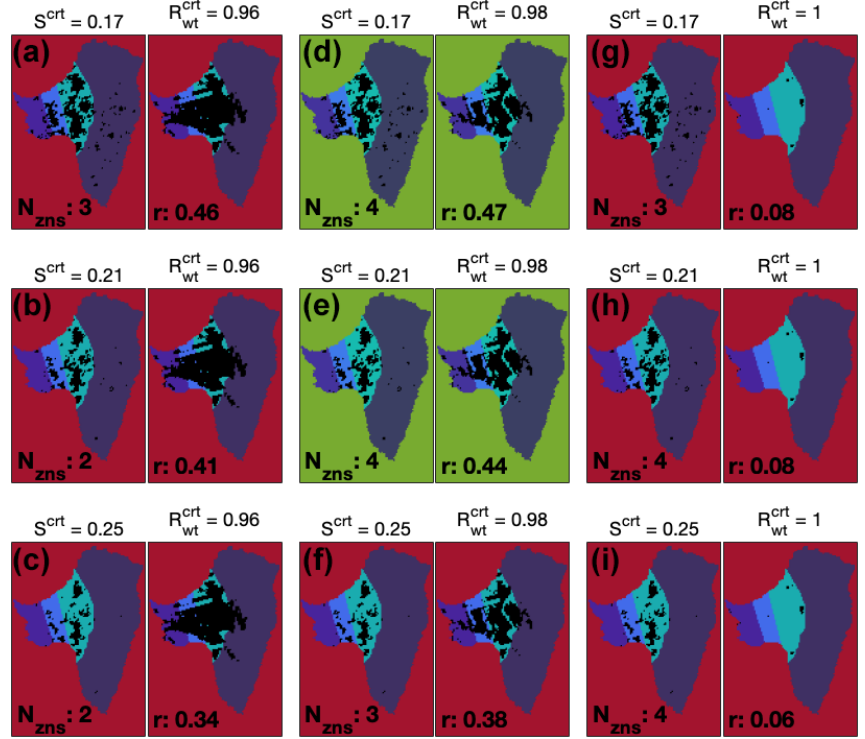
Figure B3. Select S crt (observed) and R crt wt (modeled) mask combinations from the W r = 0 . 1m, c s = 0 . 5m − 1 , k q = 5 × 10 − 2 m 7 / 4 kg − 1 / 2 , and k Q = 5 × 10 − 4 m 7 / 4 kg − 1 / 2 model run, plotted over the four zones used for the first comparison criterion (also shown in Figs. 3, 7). N zns indicates the number of zones that meet criterion 1, and r is the overall correlation between mask pairs. Background color indicates successful (green) and unsuccessful (red) matches. Values of S crt and R crt wt used to make each mask are displayed above each